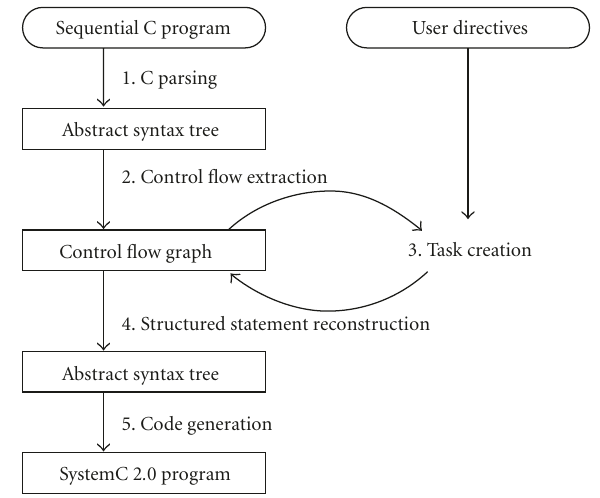
Figure 3: SPRINT consists of five phases transforming a sequen- tial C program into a parallel SystemC program. The user provided input is indicated by rounded boxes and